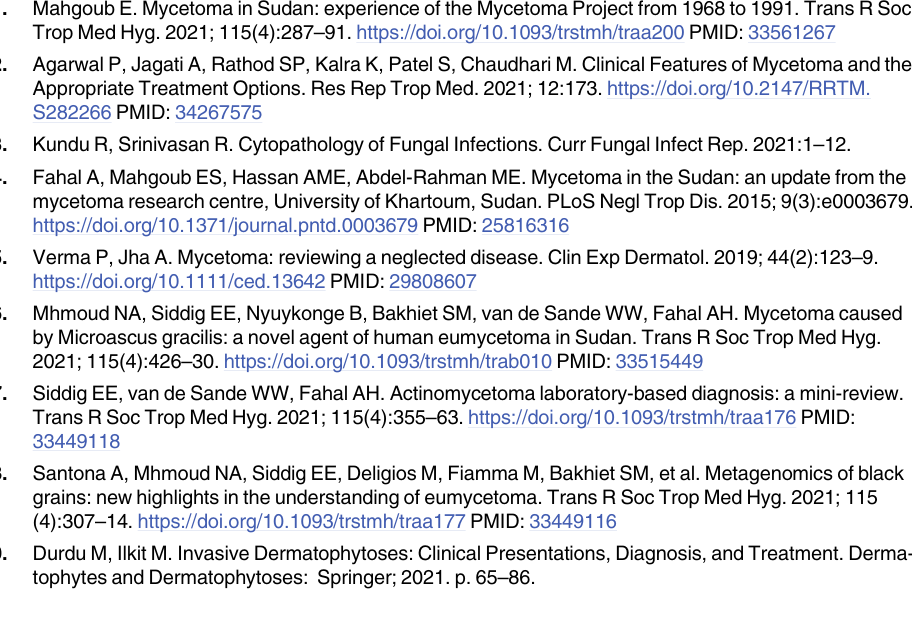
S1 Table. Estimation of eumycetoma cases by district in Sudan since 1991. (PDF) S2 Table. Estimation of actinomycetoma cases by district in Sudan since